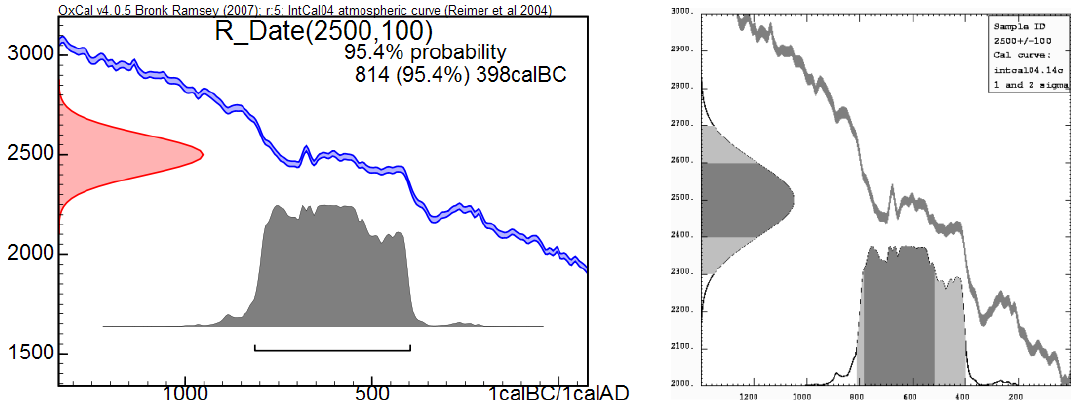
Fig. 1. Calibration graph of 2500 ± 100 14 CBP (via the IntCal04 calibration curve; Reimer et al., 2004), using OxCal 4.0 (left) and Calib 5.0 (right). The two programs give essentially the same result.